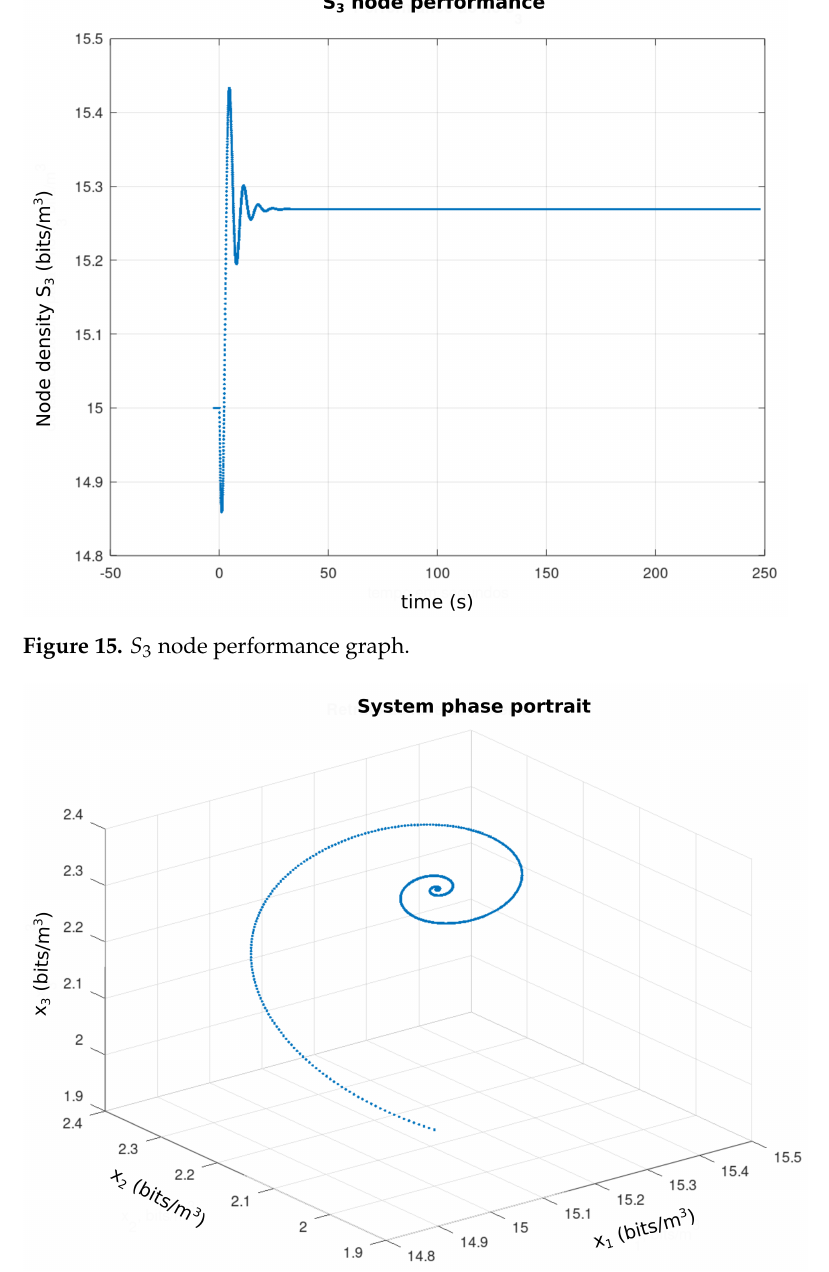
Figure 16. Phase picture of the sensor